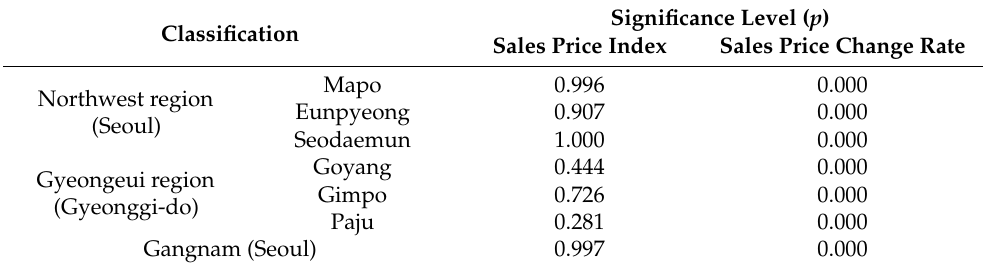
Table 7. ADF test result of sales